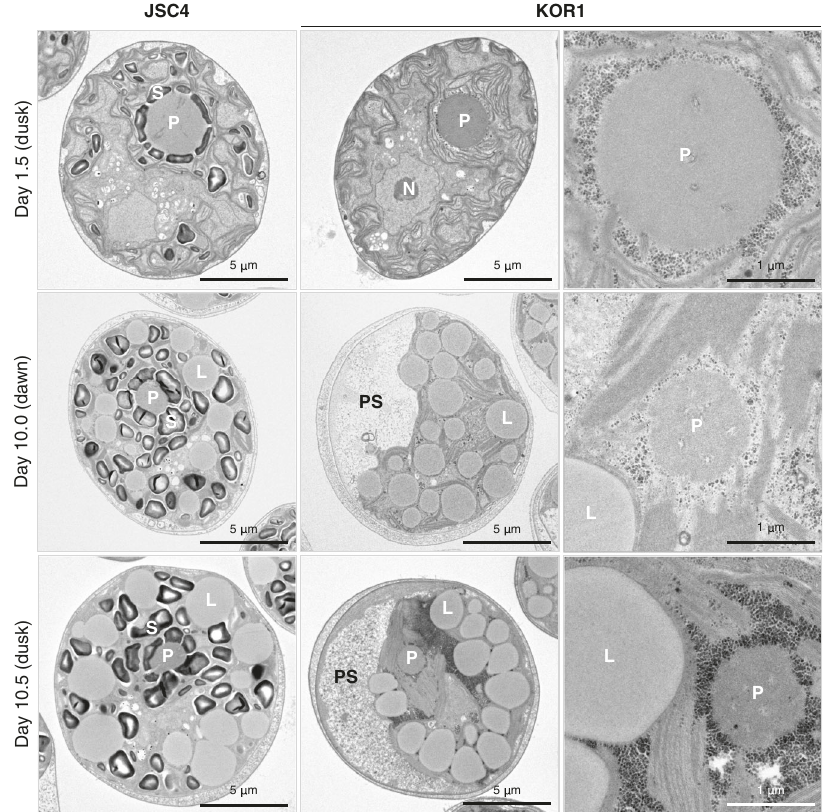
Fig. 3 Cell morphology viewed by transmission electron microscopy (TEM). Cells were harvested under nitrate-replete conditions (Day 1.5) and nitrate- deplete conditions (Day 10.0 and Day 10.5), fi xed immediately, and visualized. Day 1.5 and Day 10.5 are just before the end of a light period (dusk) and Day 10.0 is just before the end of a dark period (dawn). S: starch granule, L: lipid droplet, P: pyrenoid, N: nucleus, PS: periplasmic